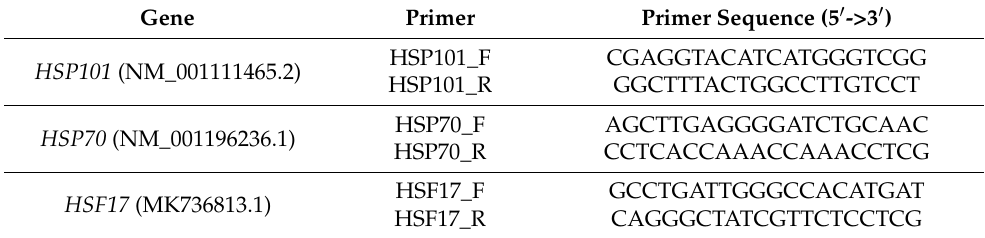
Table 2. Sequences of primers for chosen heat shock protein genes.